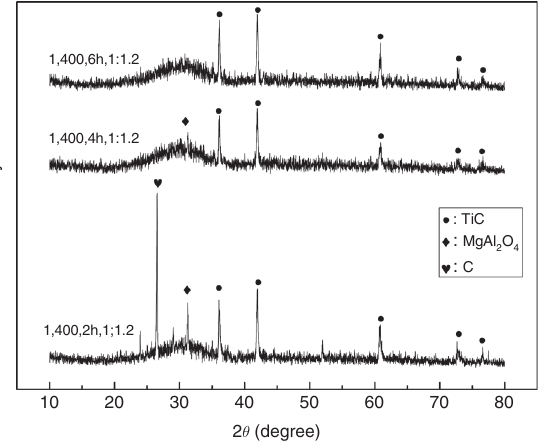
Figure 9: The percentage of total mass loss with carbon ratio of 1.15 at different temperatures